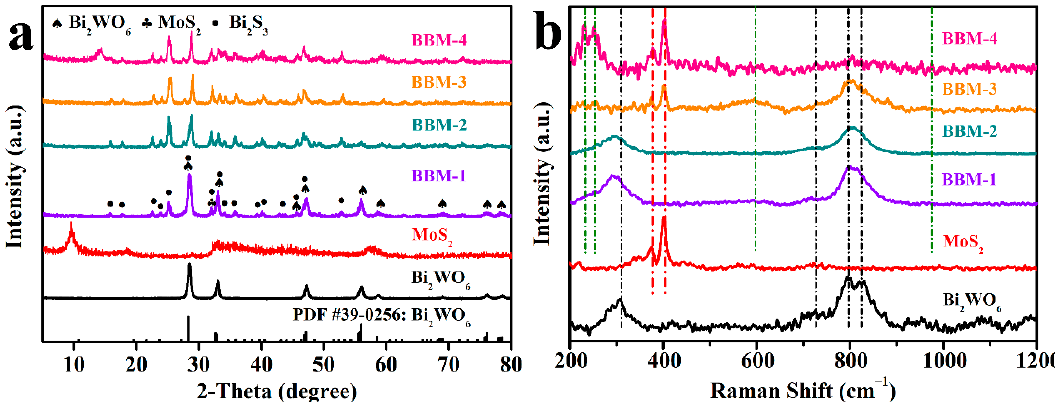
Figure 1. X-ray diffraction (XRD) patterns ( a ), and Raman spectra ( b ) of bare Bi 2 WO 6 , MoS 2 , BBM-1, BBM-2, BBM-3, and BBM-4 heterojunction.